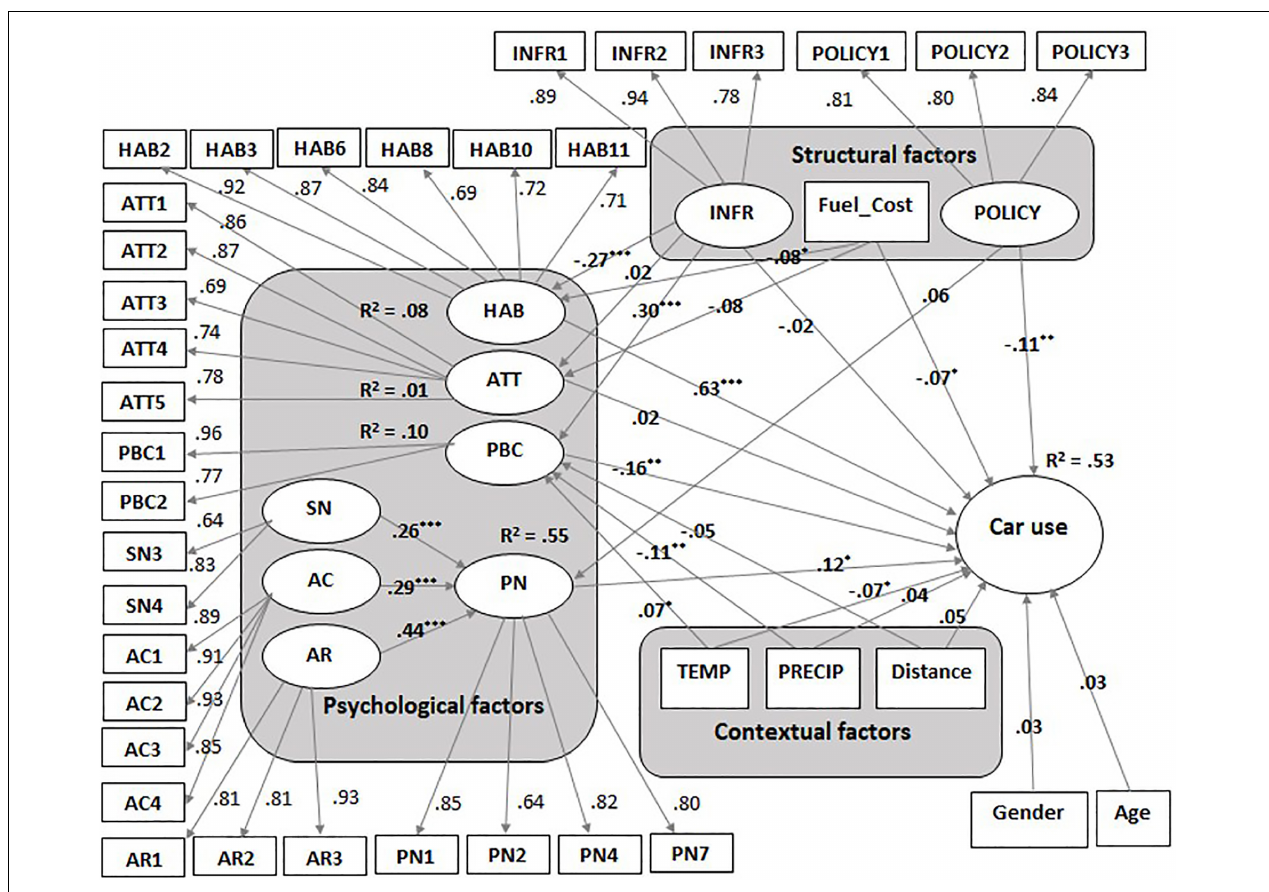
FIGURE 2 | Structural model with standardized path coefficients and explained